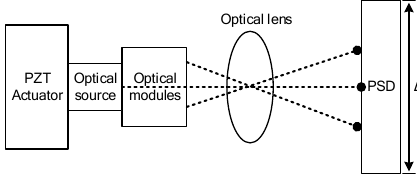
Figure 23. Configuration of fine positioning displacement detection device of PSD.